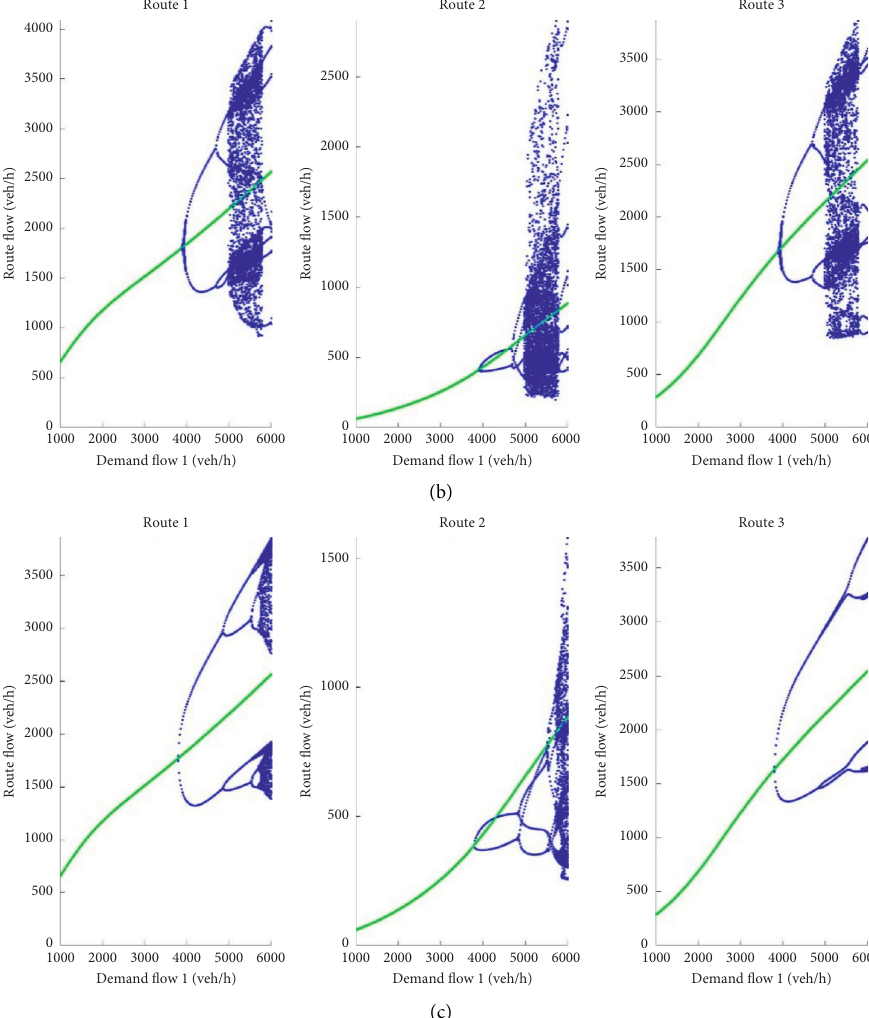
Figure 2: (a) Bifurcation diagrams of route flows, reference scenario, ES/ES. (b) Bifurcation diagrams of route flows, reference scenario, MA/ES μ � 2. (c) Bifurcation diagrams of route flows, reference scenario, MA/ES μ � 3.